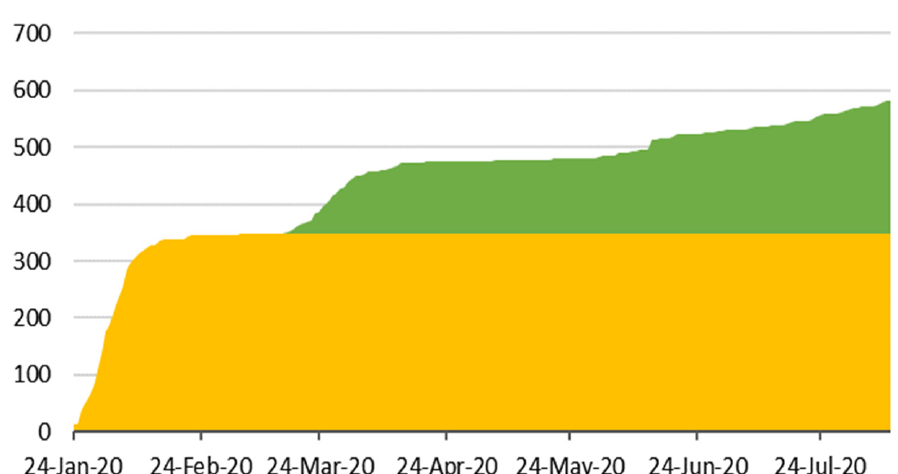
Figure 8. The cumulative curve of confirmed coronavirus 2019 (COVID-19) cases in Guangzhou, China (until 10 August 2020). The yellow curve shows the domestic confirmed cases, and the green curve shows the cases imported from overseas.